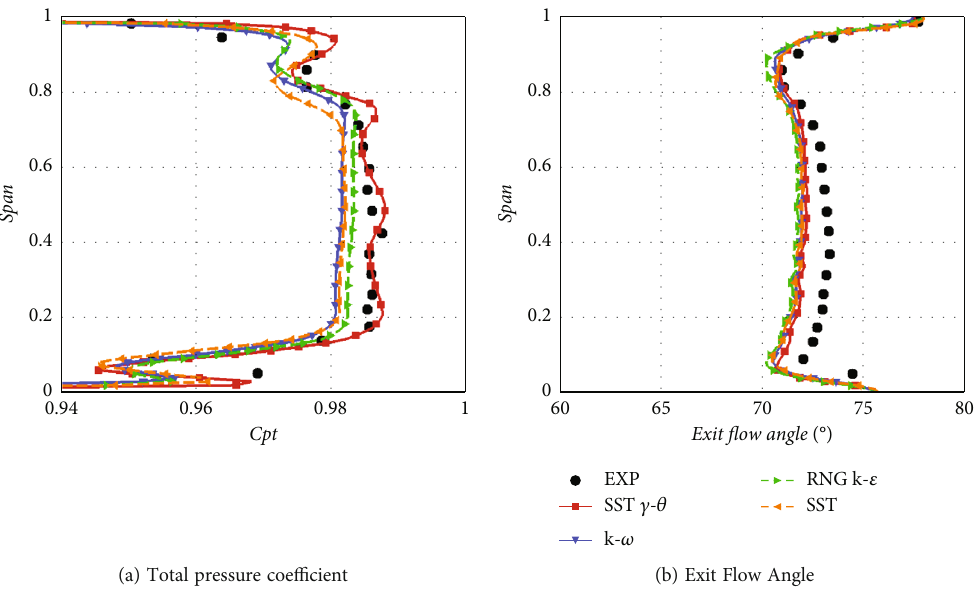
Figure 2: Comparison between the numerical results and experimental